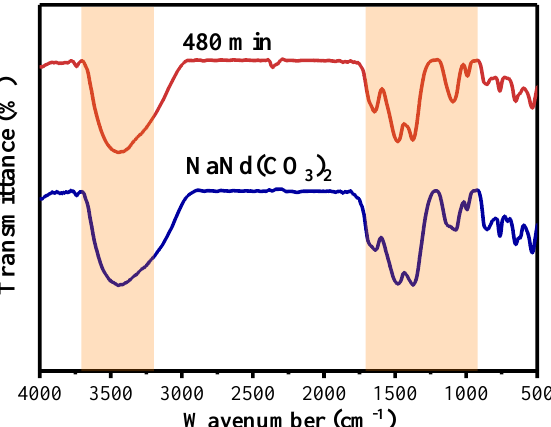
Figure 4. FTIR pattern of the neodymium precipitate, red line refers to the precipitate obtained in the presence of 0.5 mol NaCl, and blue line refers to the Comparison sample.